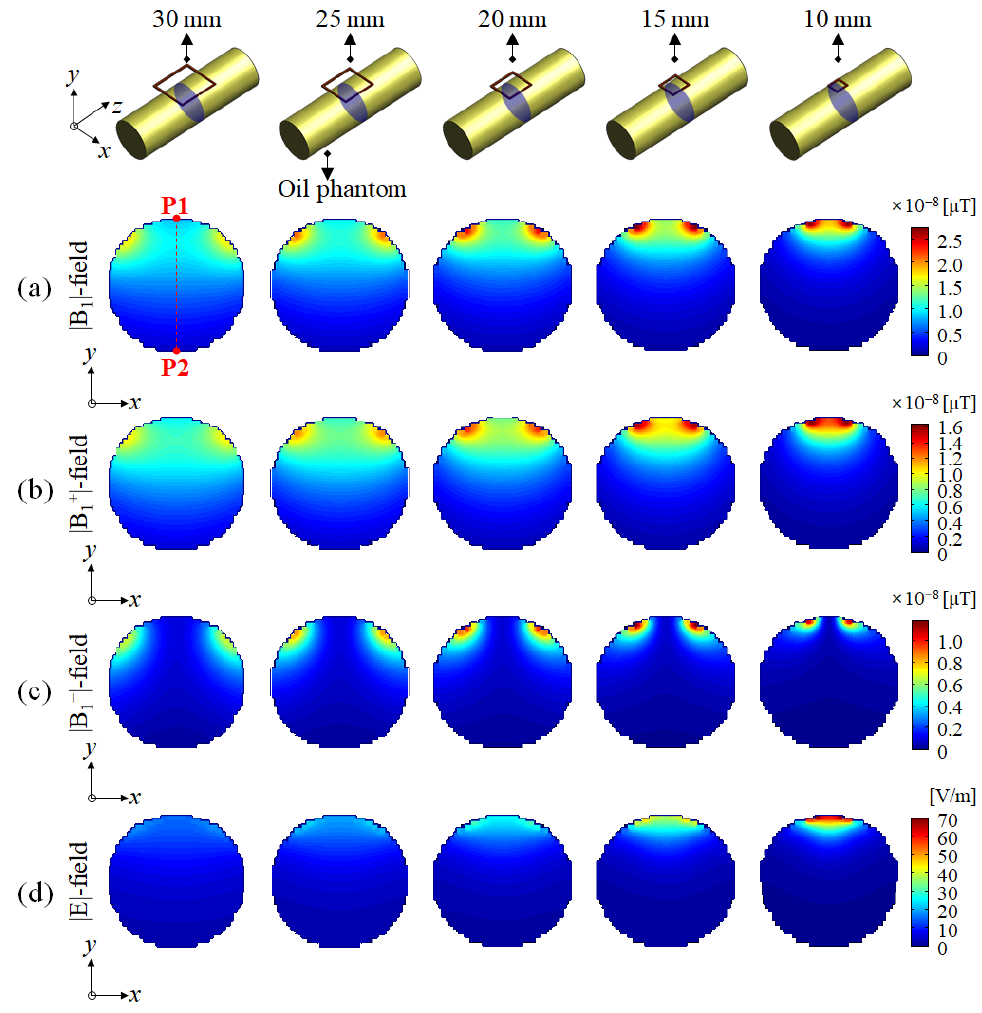
Figure 2. EM-field simulation results using oil phantom in the axial slice ( x – y plane): ( a ) |B 1 |-field, ( b ) |B 1+ |-field, ( c ) |B 1 − |-field, and ( d ) |E|-field.